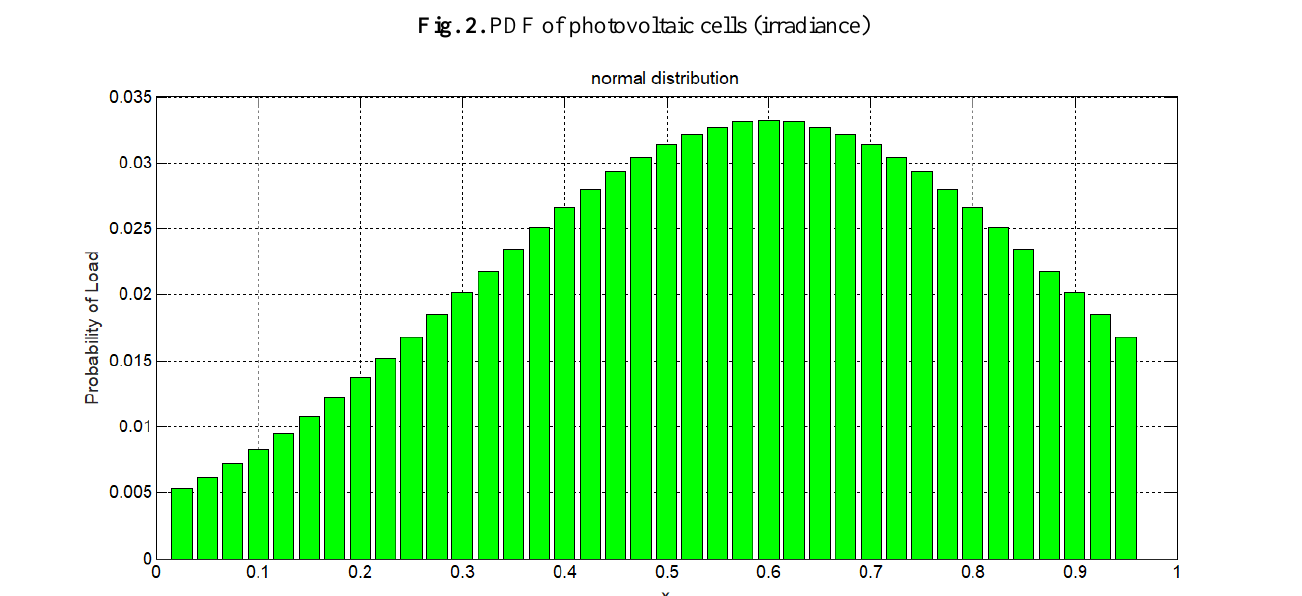
Fig. 3. Normal PDF of load